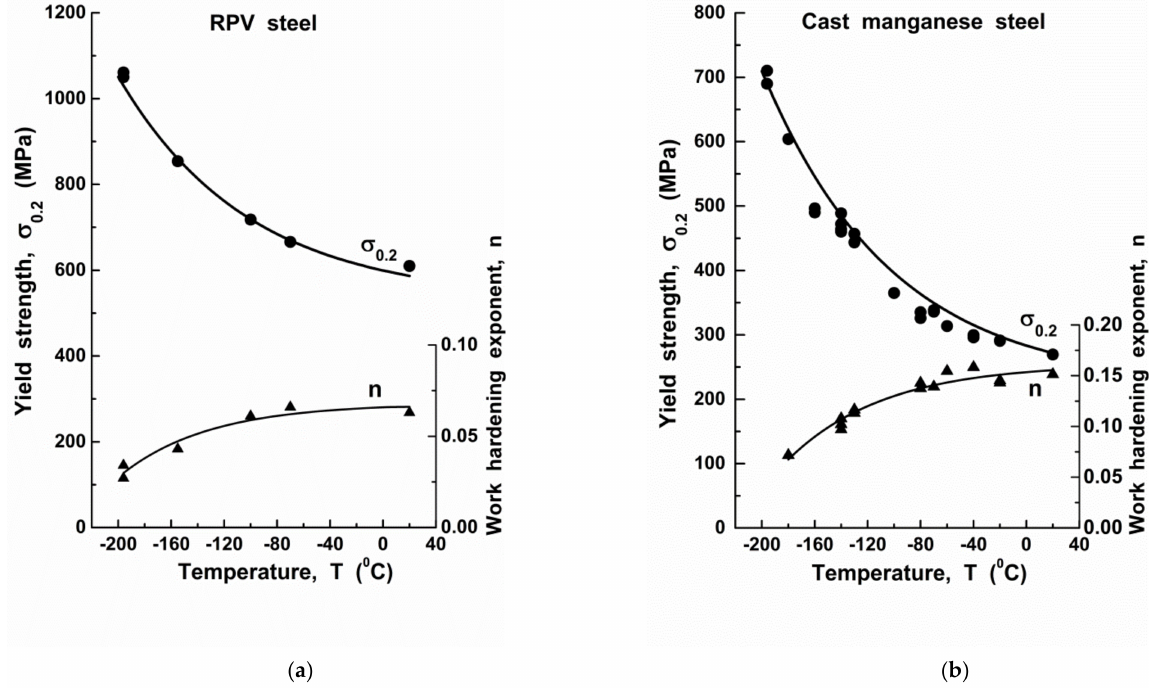
Figure 2. The temperature dependences of yield strength σ 0.2 and work hardening exponent n for RPV steel ( a ) and cast manganese steel ( b